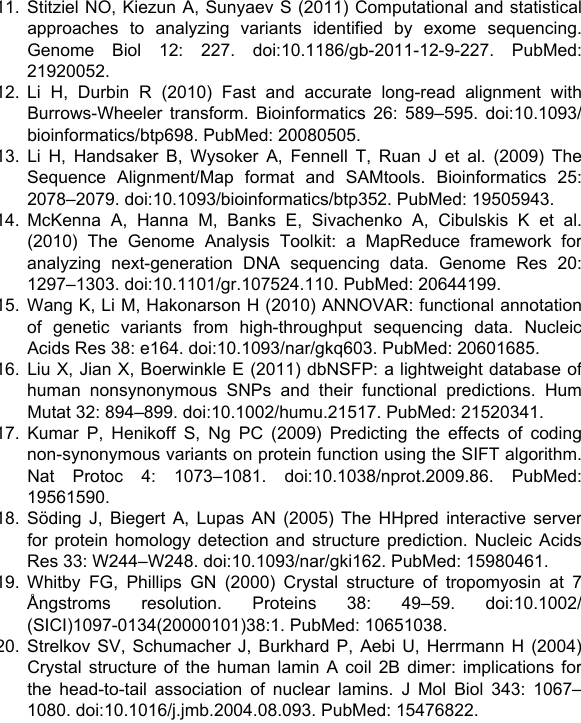
Table S3. SNVs that pass the filtering criterions and match to the autosomal dominant